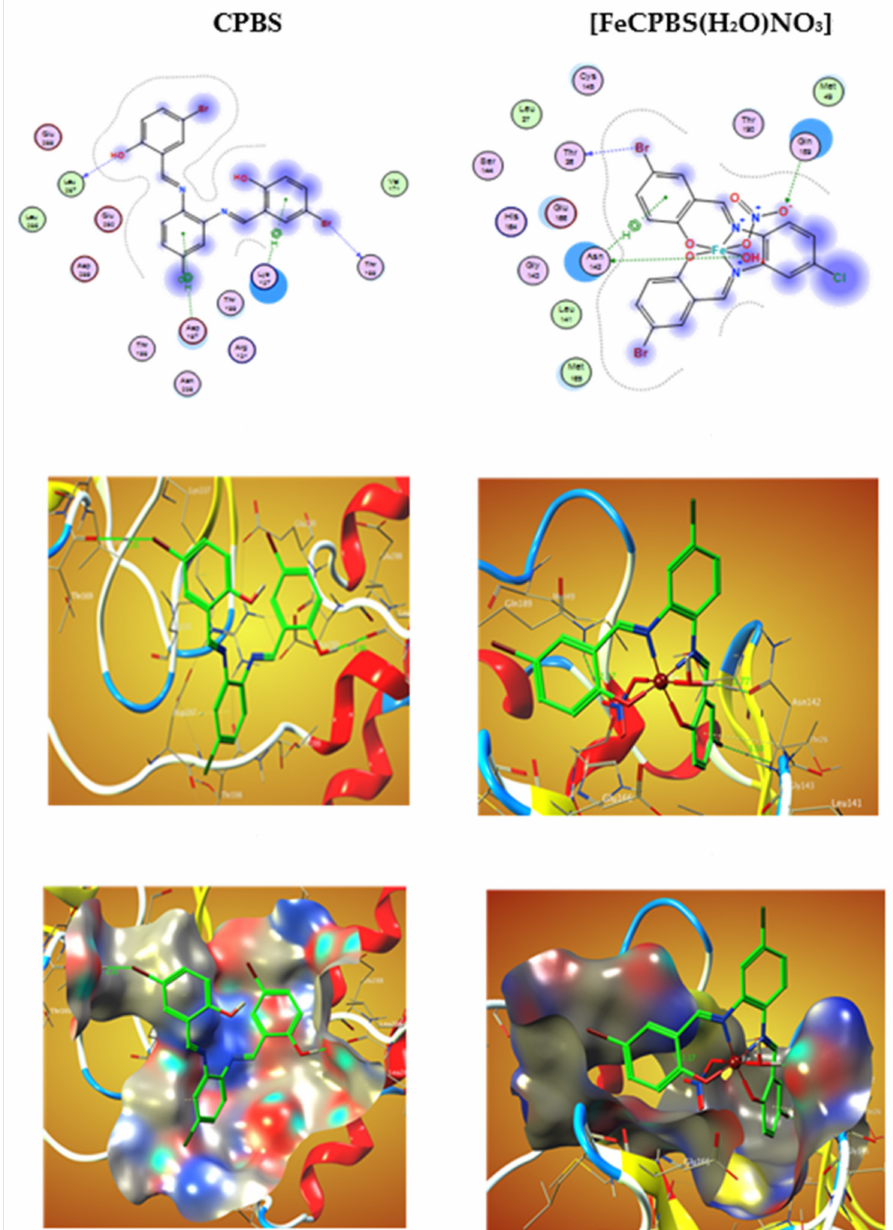
Figure 12. 2D and 3D plots of the interaction between CPBS and [FeCPBS(H 2 O)NO 3 ] with the active site of the receptor of viral protein (PDB ID: 6lu7). Dotted curves depict hydrophobic interactions with amino acid